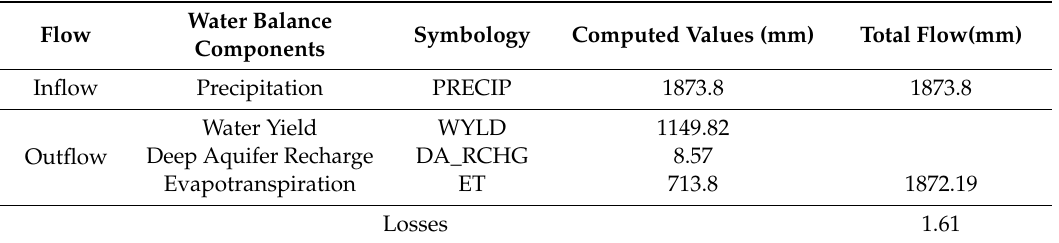
Table 3. Average annual water balance for Haro River watershed